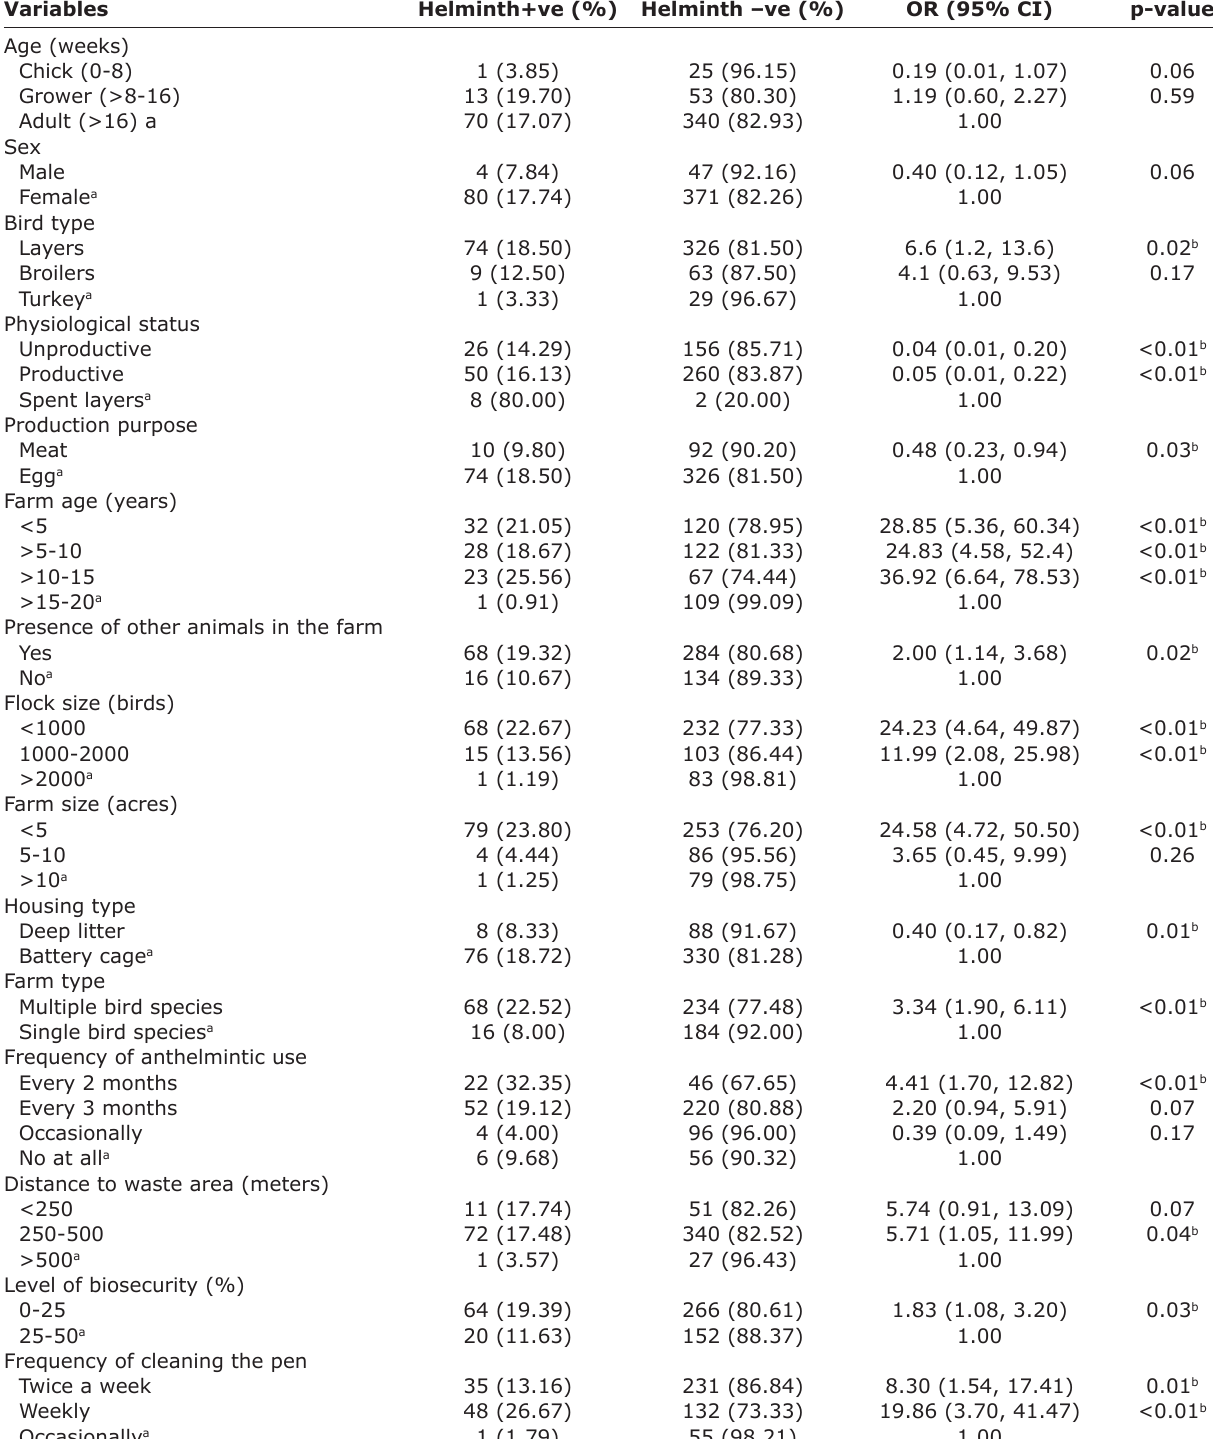
Table-4: Risk factors associated with helminth infections among intensively managed poultry in Kwara Central, Kwara State.